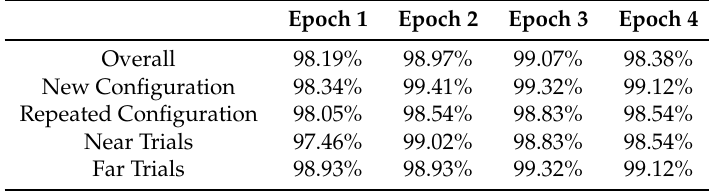
Table 1. Percentage of correct answers per epoch for all configuration and trial